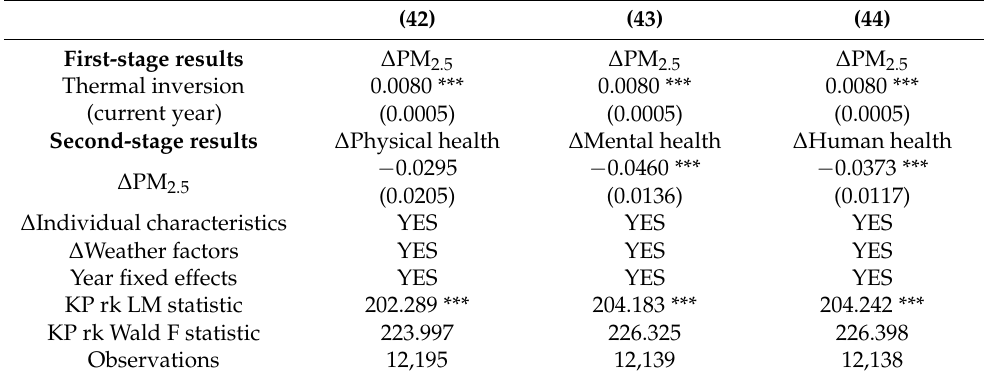
Table 13. LD estimates of influence of air pollution on physical, mental, and human health (eight